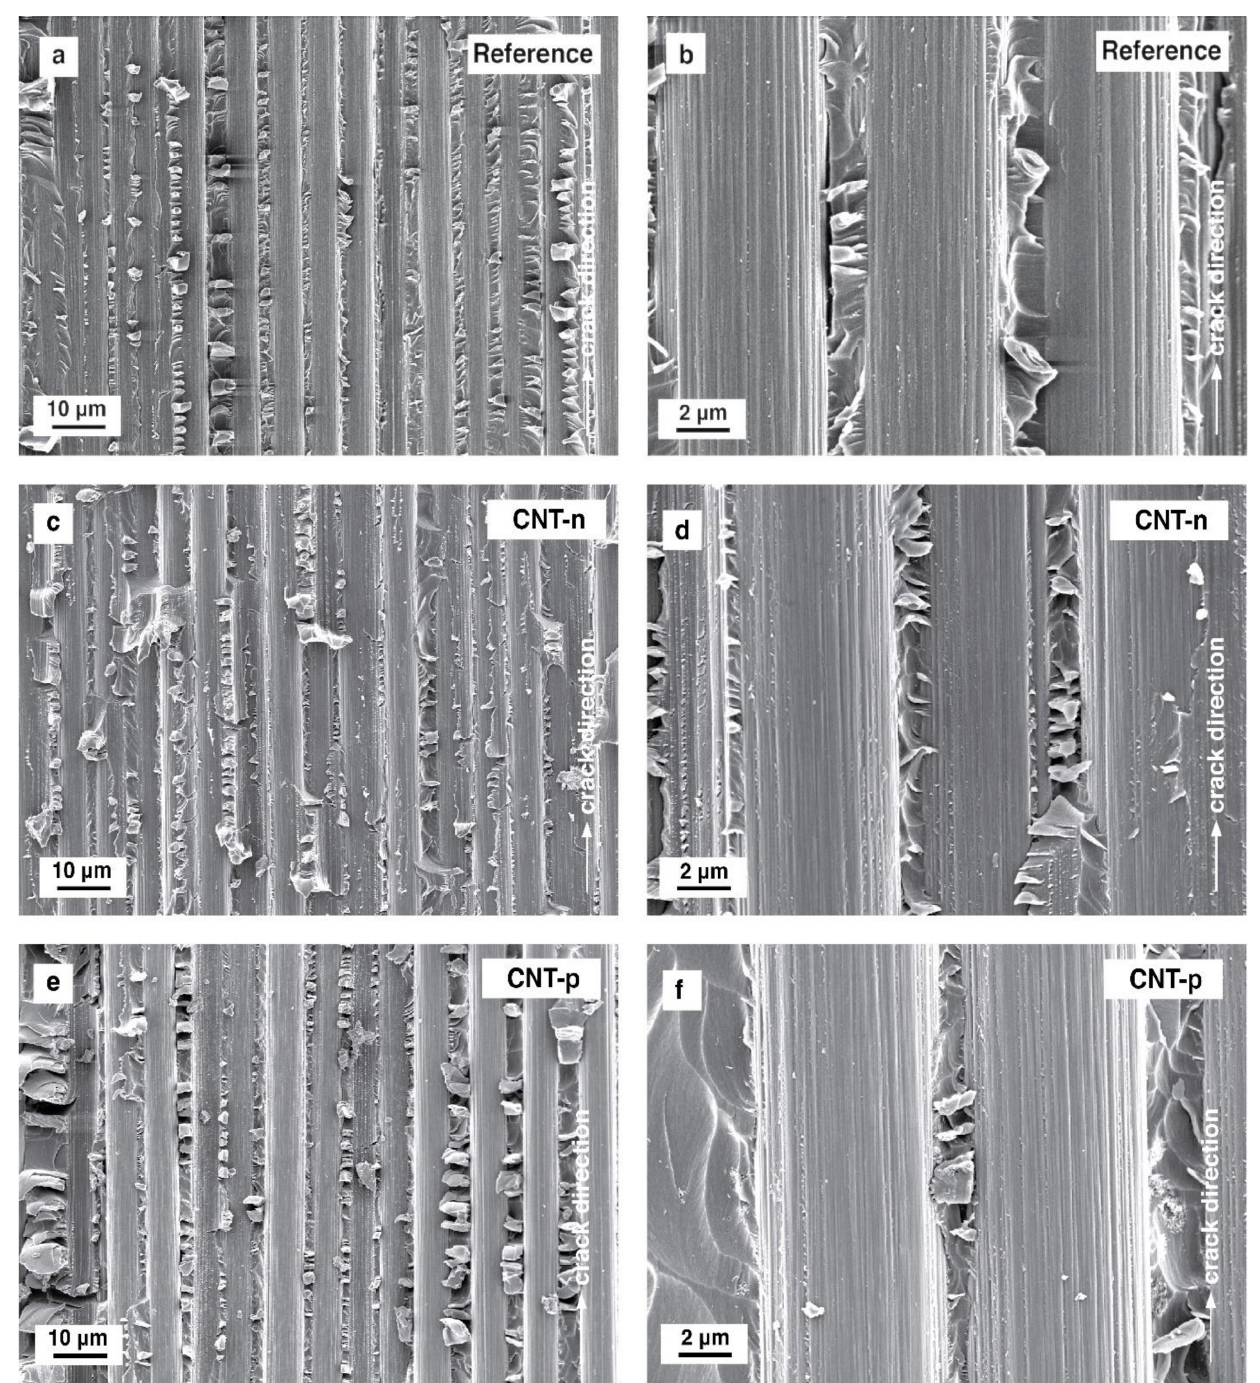
Figure 11. Scanning electron micrographs of mode II fracture surfaces from ( a ) and ( b ) neat, ( c ) and ( d ) 0.5 wt.% CNT-n modified, and ( e ) and ( f ) 0.5 wt.% CNT-p modified epoxy–carbon fiber UD